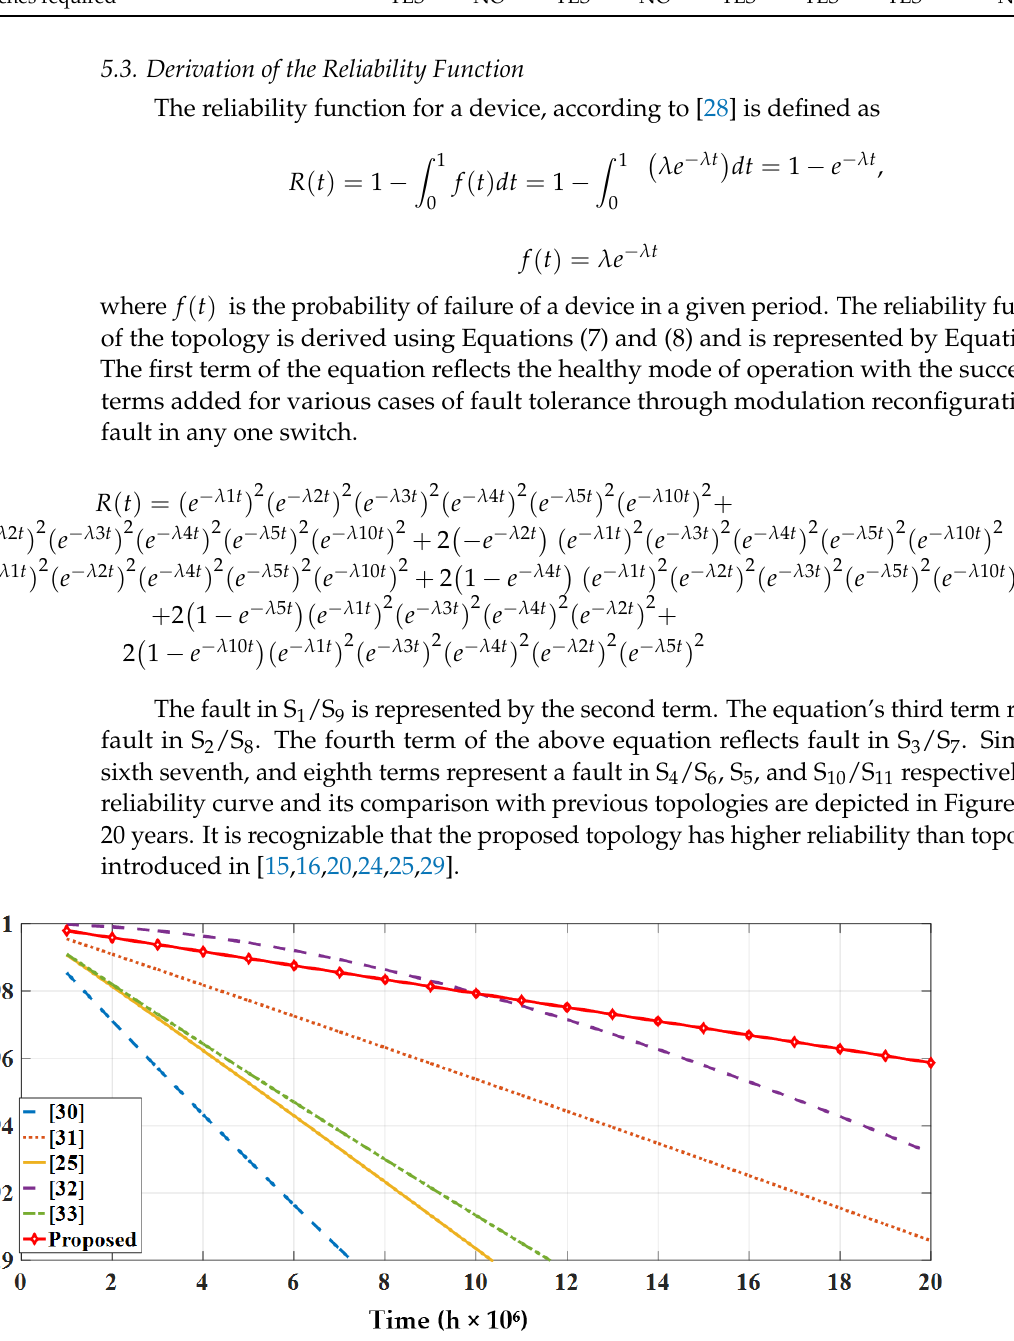
Figure 13. Reliability comparison with previous literature.